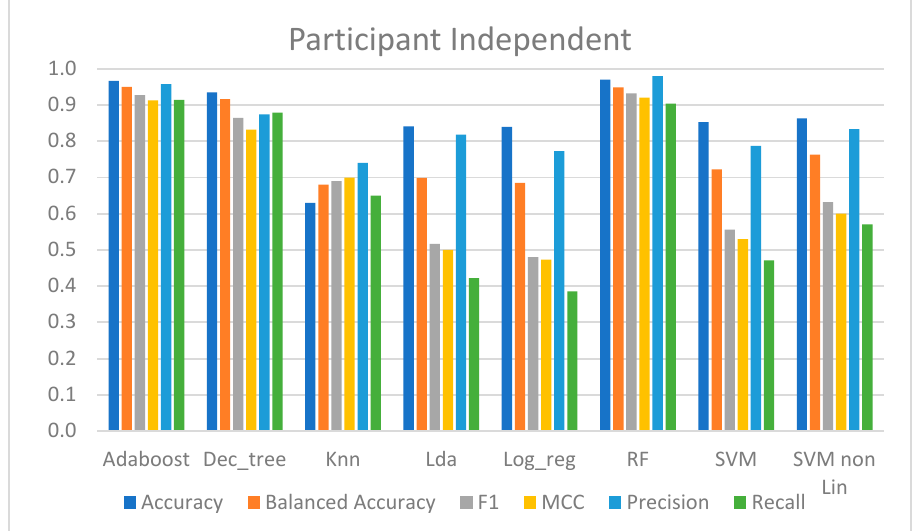
Figure 10. Metrics for performance evaluation of participant-independent approach.